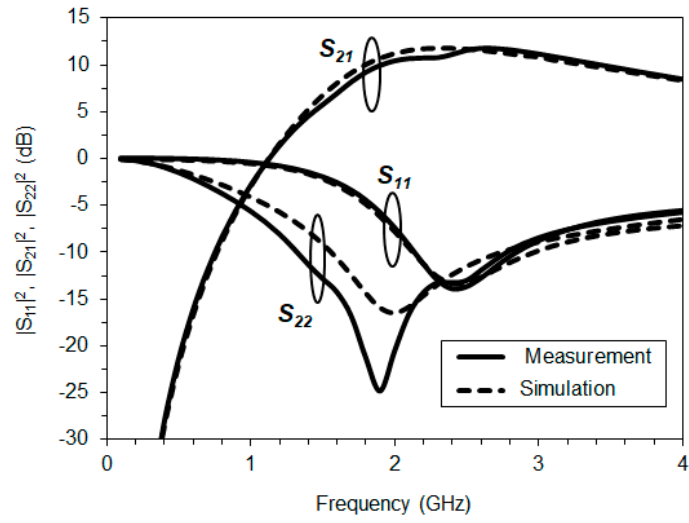
Figure 12. The measurement results (solid line) versus the simulation results (dashed line) of S 11 , S 21 , and S 22 of the proposed PA IC at 1 V of supply voltage.